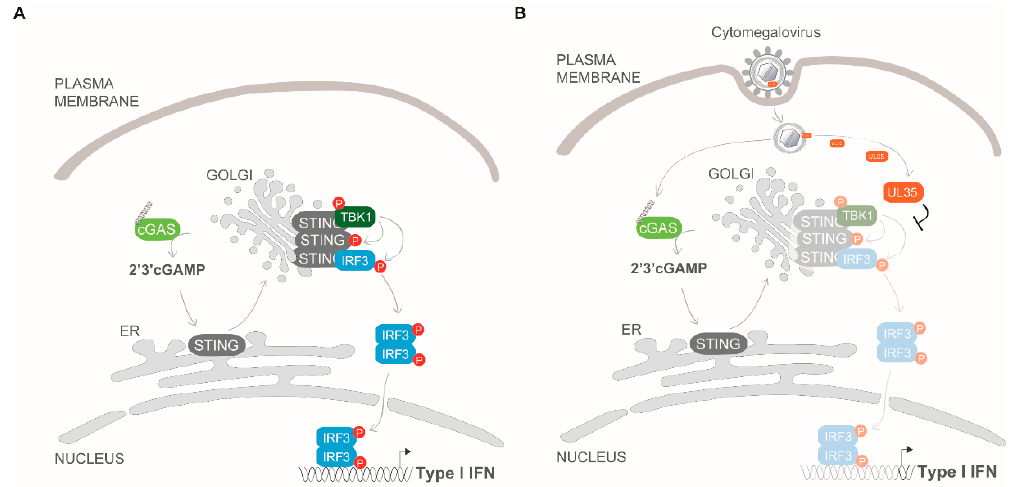
Figure 8. UL35 targets TBK1 to antagonize type I IFN signaling. Nucleic acids ( A ) or CMV infection ( B ) are recognized via sensors such as cGAS, which triggers signaling via TBK1 and IRF3 to induce transcription of IFN β . ( B ) Following viral entry, tegument UL35 targets TBK1 to downmodulate the type I IFN response. Figure S1: UL35 inhibits IFN β transcription independent of DCAF1 or Cul4A, Figure S2: Whole cell proteomics of HFF-1 stably expressing ev or UL35, Supplementary Table S1: Proteomics